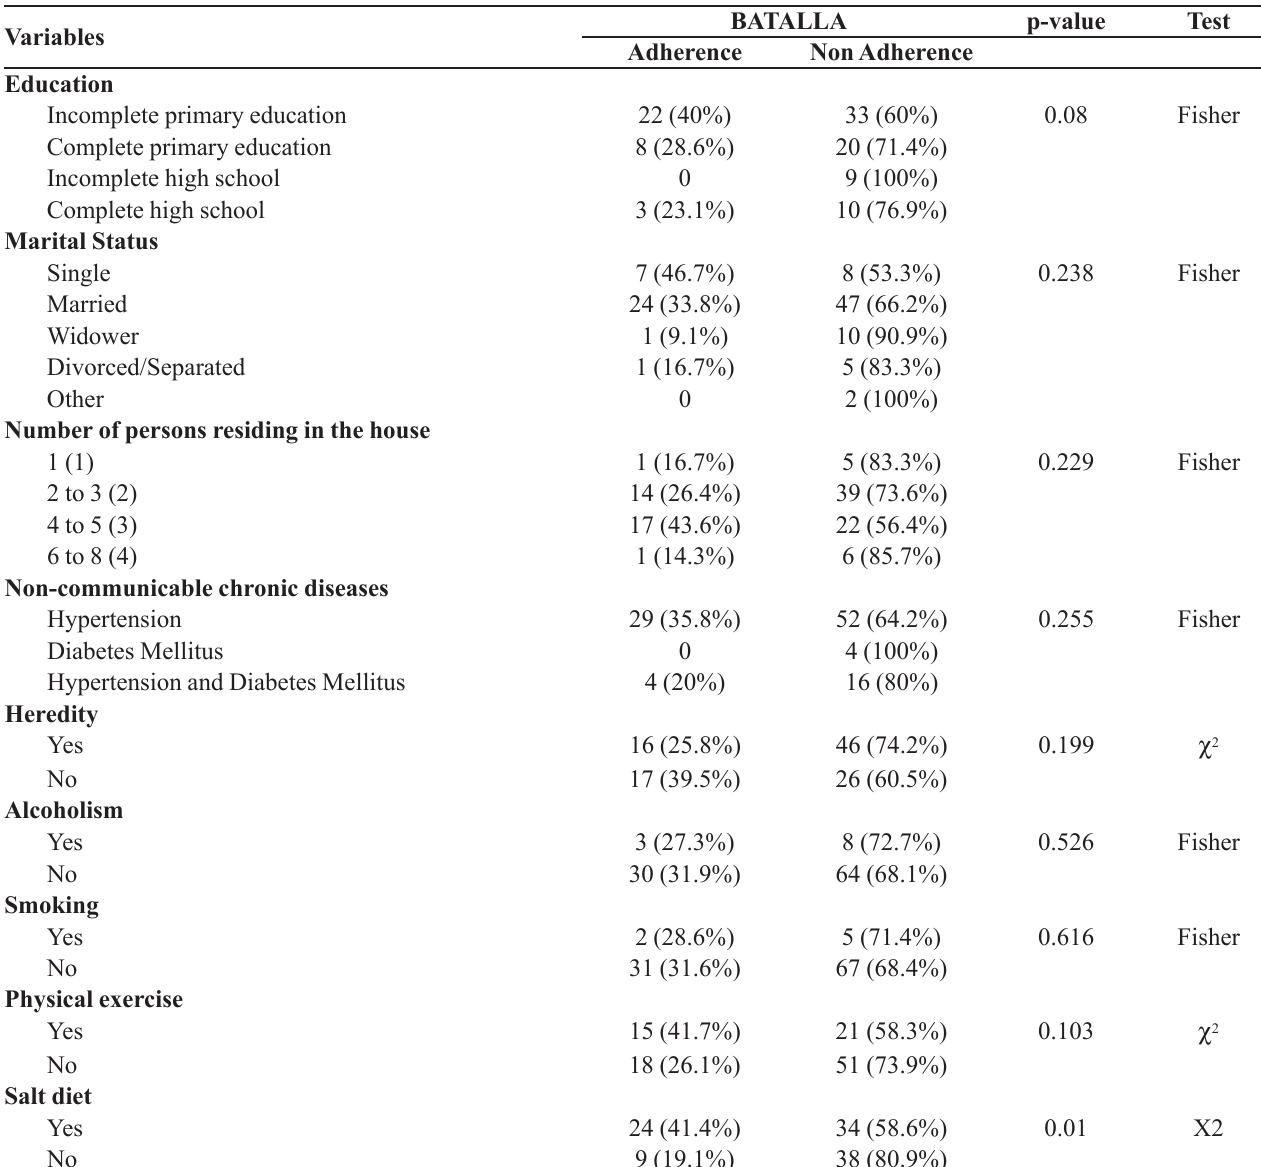
TABLE III - Distribution of sociodemographic and economic variables of Hiperdia users to analyze the association between the variables and adherence to BT